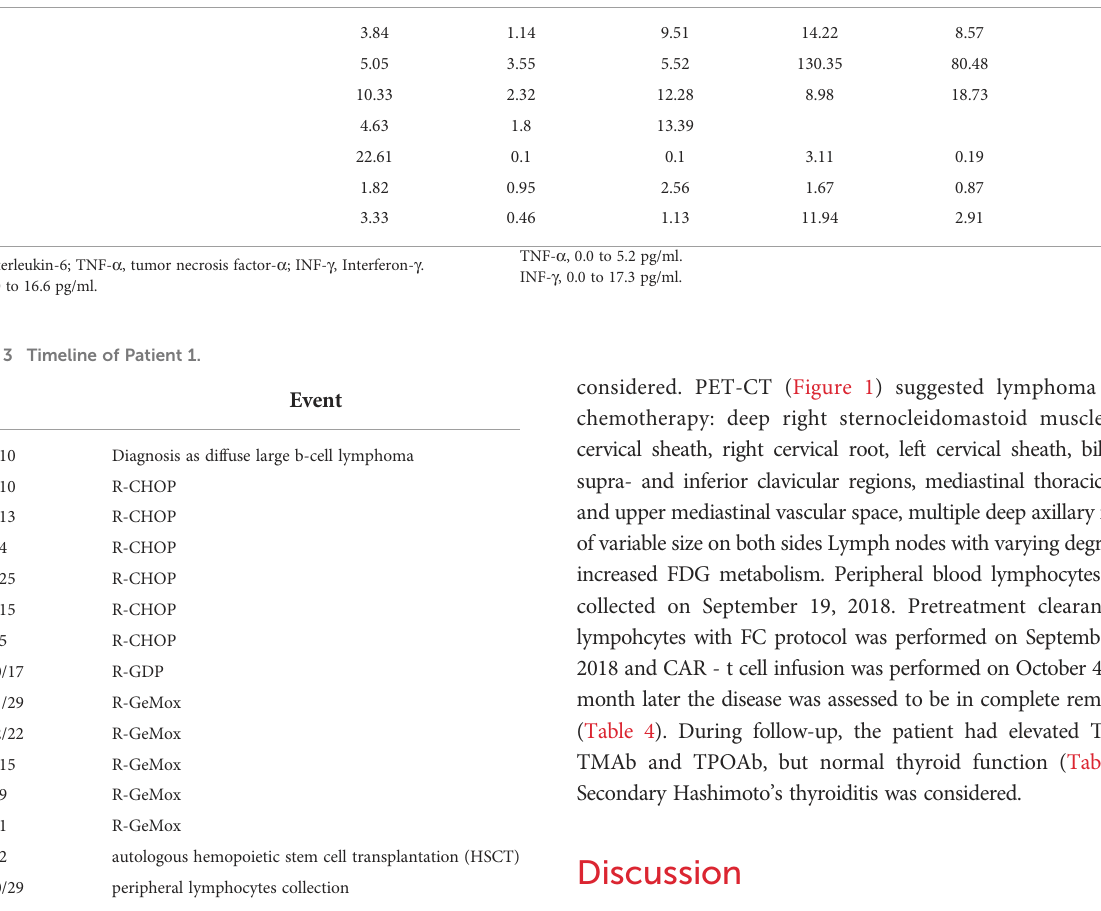
CAR - T cell therapy is a novel biological therapy in which T cells are genetically transduced to express speci fi c CAR - T proteins that speci fi cally recognize target antigens and kill target tumor cells (1). The major adverse effects of CAR - T cell therapy are cytokine